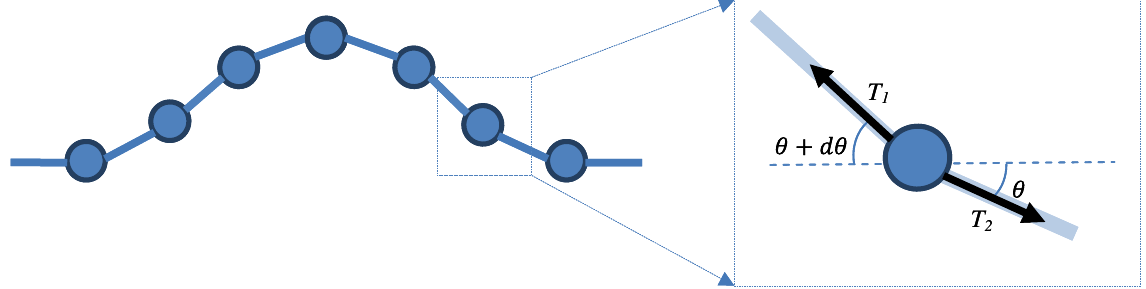
FIG. 1. String-and-bead